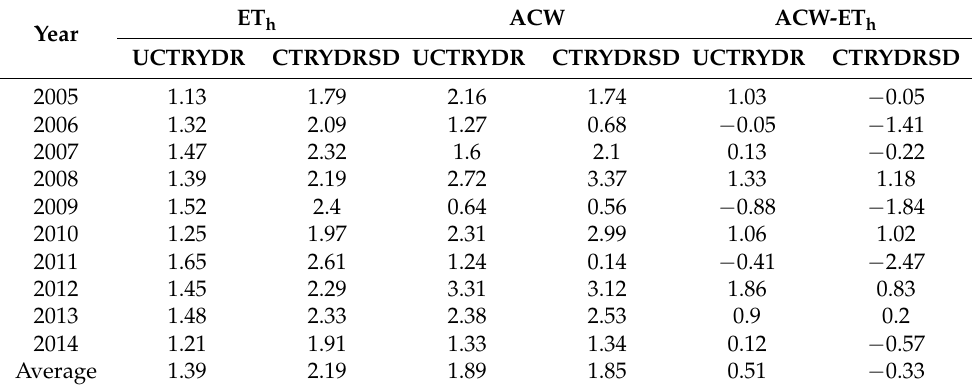
Table 5. ET h , and the ACW in the UCTRYDR and CTRYDRSD regions from 2005 to 2014 (10 9 m 3 ).